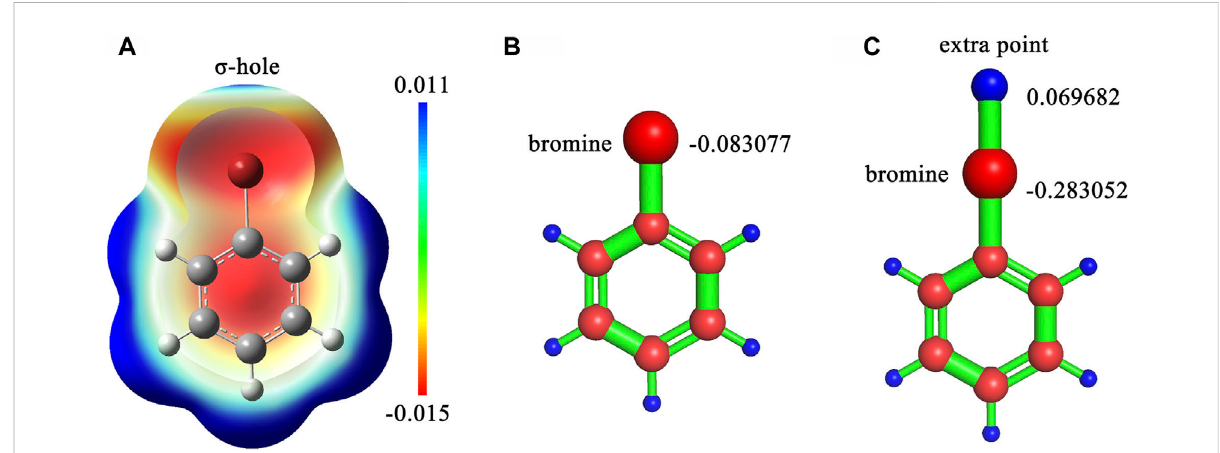
FIGURE 1 (A) The sigma-hole effect in bromobenzene molecule. (B) The RESP charge on the bromine atom without an extra point in bromobenzene. (C) The RESP charges on the bromine atom and the extra point in bromobenzene. The calculation was processed at B3LYP/6-311G (d,p) level.